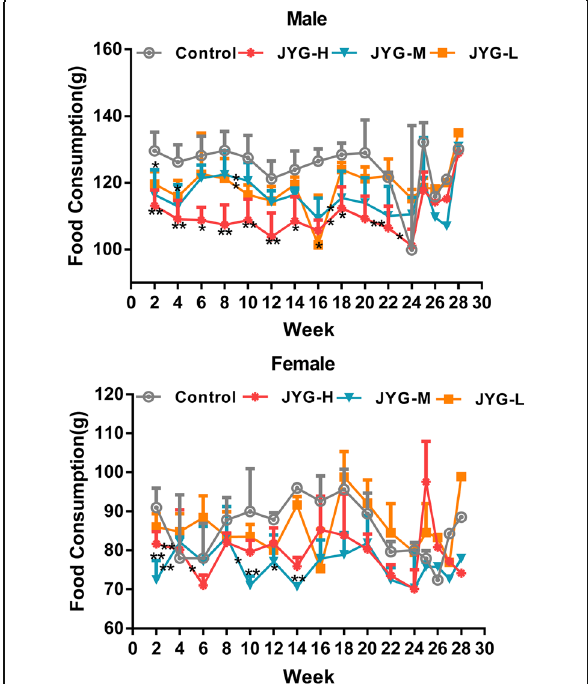
Fig. 2 Food consumption in the control and JYG-treated groups in the chronic toxicity test. Note: JYG-H, JYG-M,JYG-L: Jueyin granules high-dose, medium dose, low-dose group, respectively. The values are expressed as mean ± SEM ( n = 10 rats for 3 months; n = 17 – 19 rats for 6 months; n = 10 rats for 1 month recovery). * P < 0.05; ** P < 0.01 statistically significant compared to control